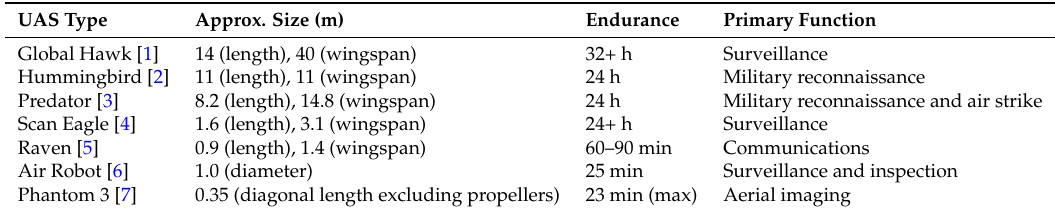
Table 1. A brief overview of various Unmanned Aerial System (UAS) platforms and